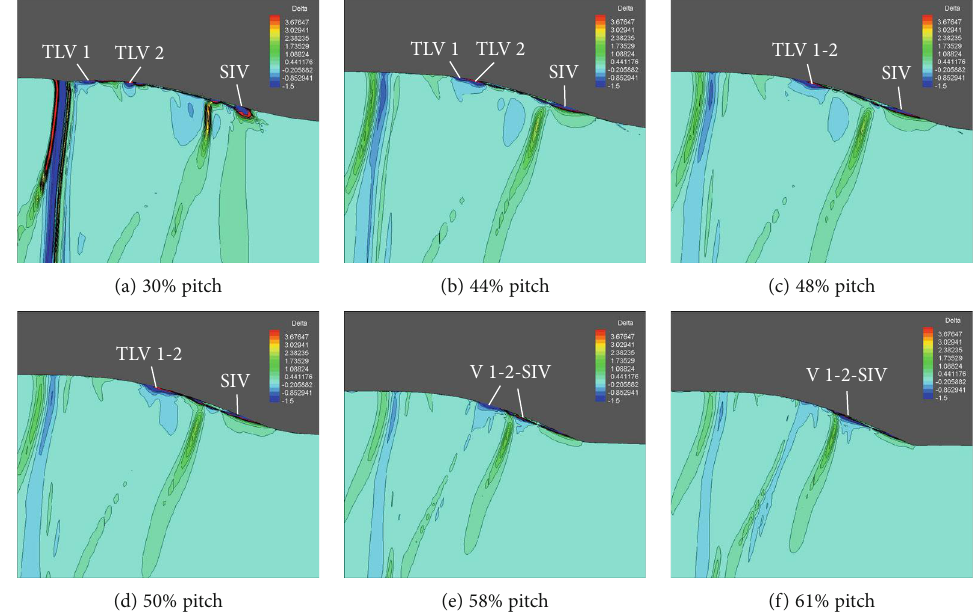
Figure 24: Discrimination of shock-induced vortex stability by parameter Delta at near-peak e ffi ciency